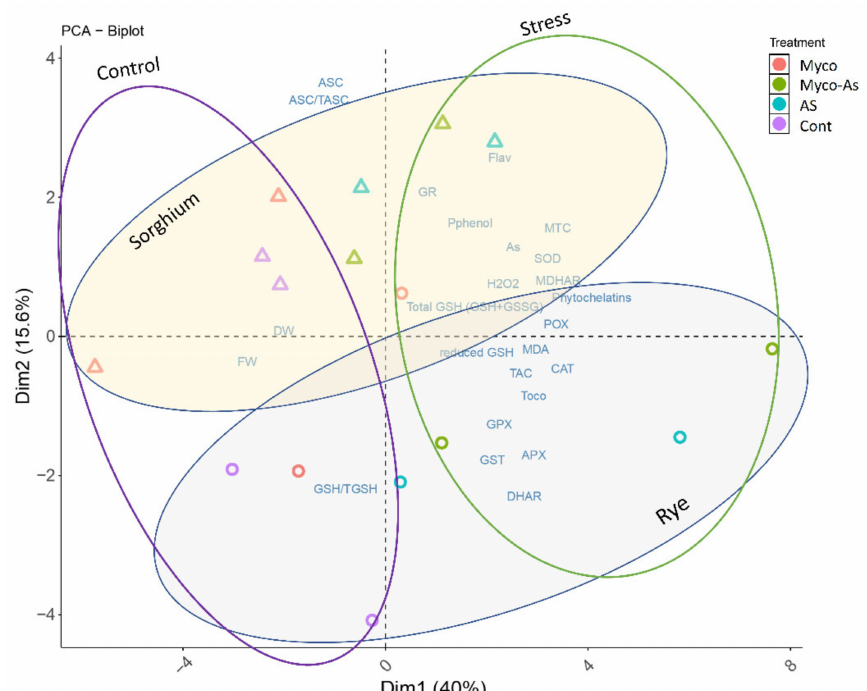
Figure 7. Principal component analysis (PCA) of vanadium accumulation, growth, MTC, PC, enzymatic and nonenzymatic antioxidants in shoots and roots of six-week-old rye and sorghum grown in soils with 0 or 350 mg/kg soil sodium vanadate and with or without soil enrichment with inoculum of the mycorrhiza Rhizophagus irregularis